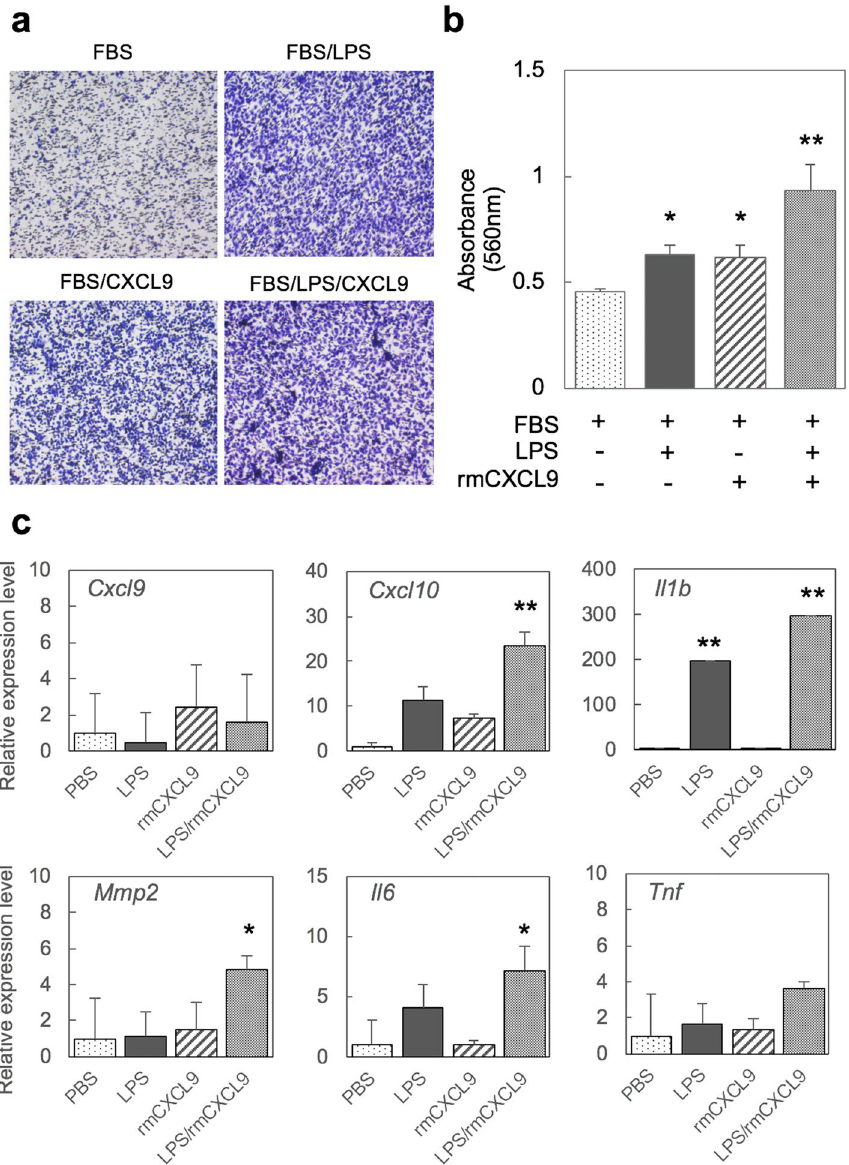
Figure 5. CXCL9 induces macrophage migration and enhances the inflammatory response to LPS. ( a ) Representative images of peritoneal macrophages that have moved through the membrane. Peritoneal macrophages were stained using a commercial solution in accordance with the manufacturer’s protocol. ( b ) Cell migration assay for 24 h was analyzed using the colorimetric absorbance at 560 nm (mean ± SD, n = 4 per each group). ( c ) Validation of the inflammatory markers by quantitative PCR analysis. Statistical analysis was conducted using the Dunnett test to compare with the PBS group; *p < 0.05, **p < 0.01 (mean ± SD, n = 4 per